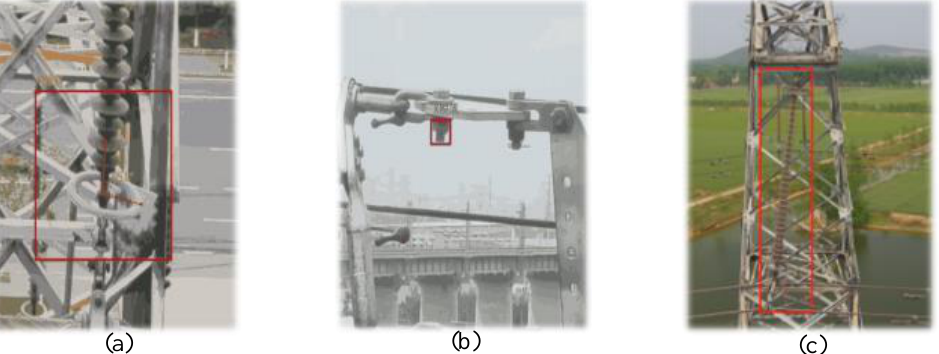
Figure 16. ( a ) The grading ring is displaced; ( b ) The locking pin is defective; ( c ) The insulator string is